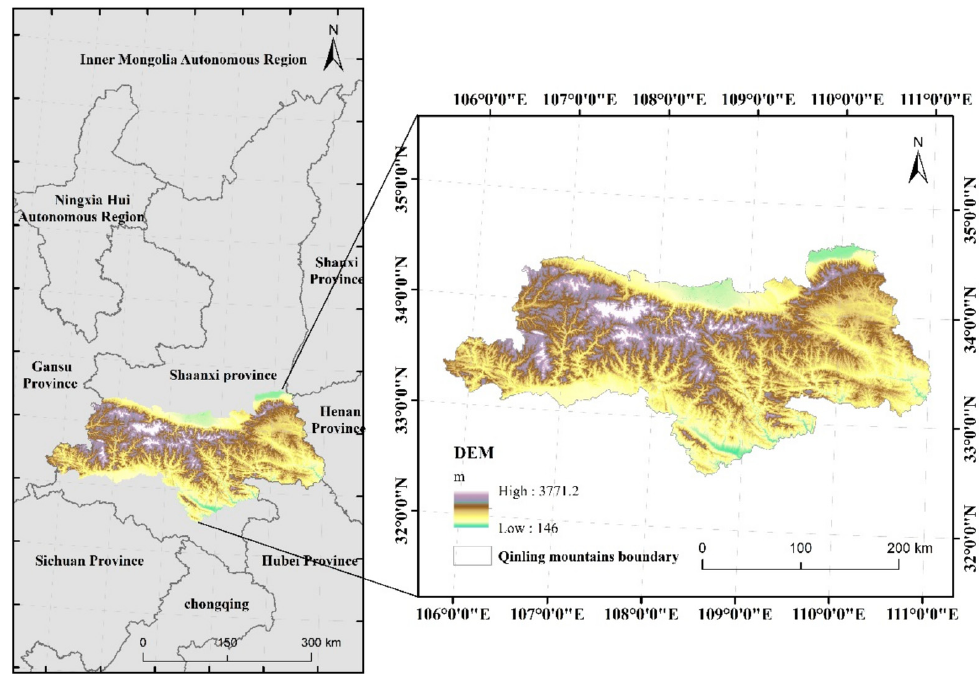
Figure 1. Overview of the study